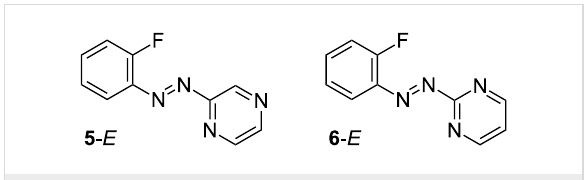
Figure 4: Strcutures of trans azo derivatives 5 -E and 6 -E